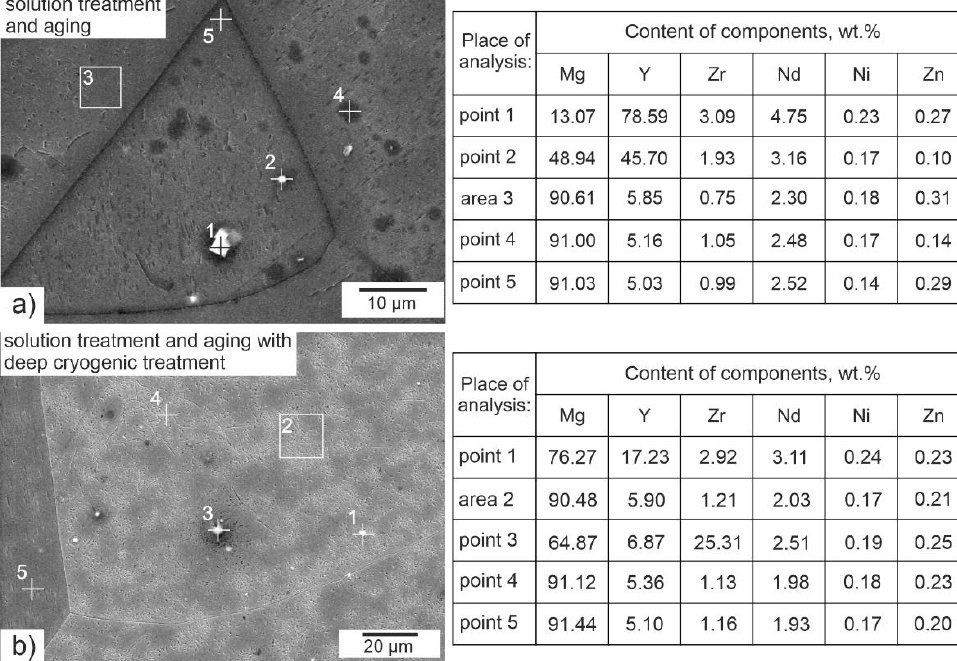
Figure 4. X-ray diffraction pattern (XRD) of the Mg-Y-Nd alloy after precipitation hardening ( a ) and after precipitation hardening with a deep cryogenic treatment ( b ).